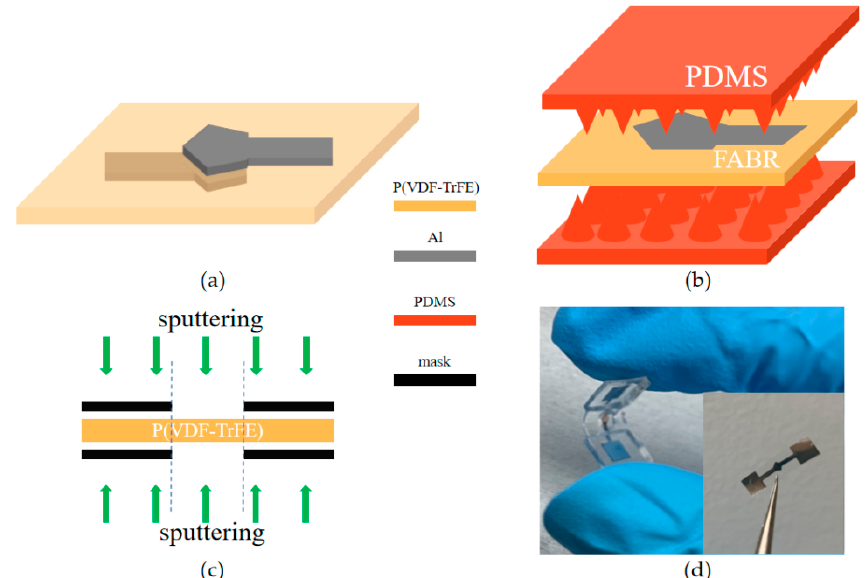
Figure 2. ( a ) Structural schematic of the P(VDF-TrFE) FBAR; ( b ) the exploded schematic diagram of